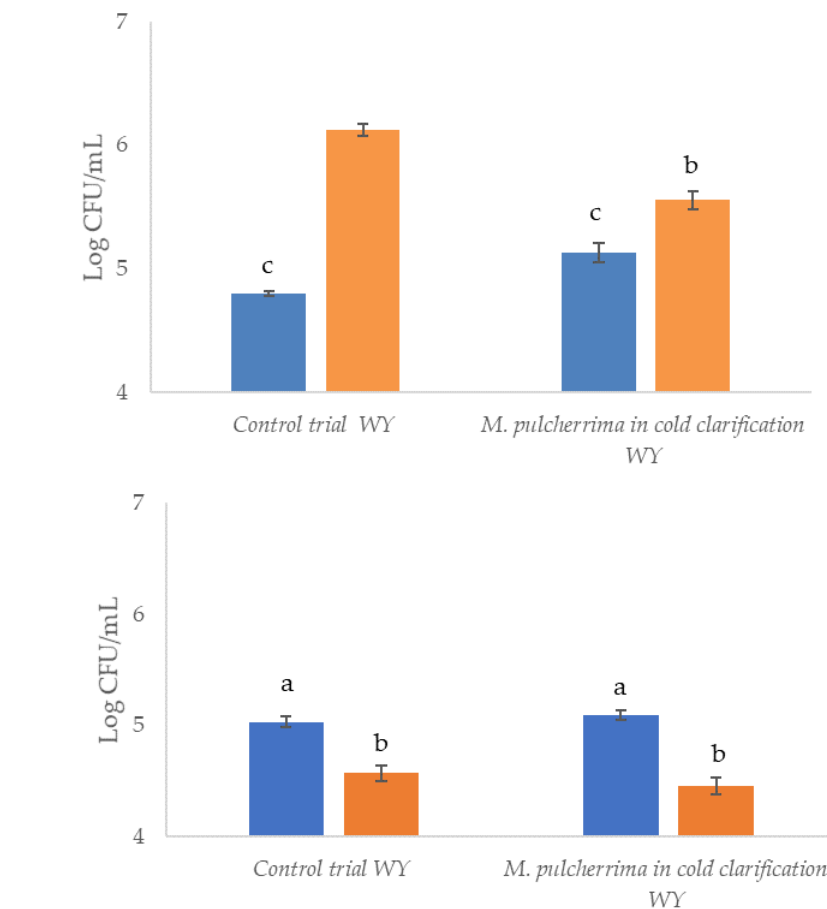
Figure 1. Effect of M. pulcherrima addition in cold clarification on wild yeasts (WY) in comparison with control fermentation: ( a ) 2021 vintage and ( b ) 2022 vintage. before clarification; after clarification. Data (n = 3) are the means ± standard deviation. Data with different superscript letters ( a,b,c ) are significantly different (Duncan tests; p < 0.05).